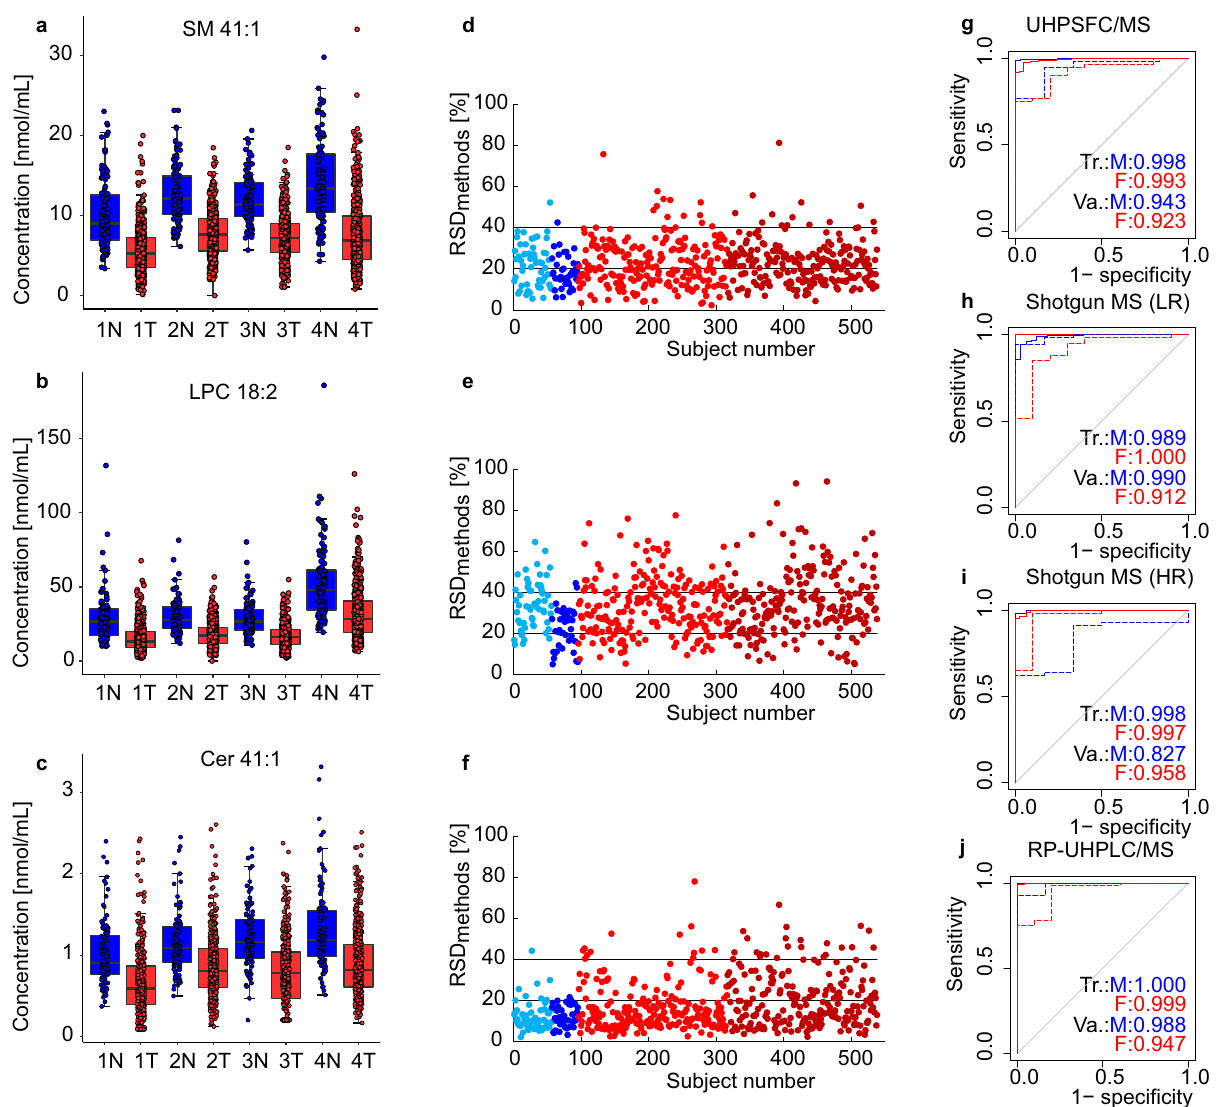
Fig. 4 Comparison of Phase II results obtained at three different laboratories using four mass spectrometry-based approaches. Box plots of lipid concentrations normalized to the NIST reference material for samples obtained from PDAC patients (443 T) and healthy controls (95 N) of both genders including both validation and training sets: a SM 41:1, b LPC 18:2, and c Cer 41:1 for UHPSFC/MS (Method 1), shotgun MS (LR) (Method 2), shotgun MS (HR) (Method 3), and RP-UHPLC/MS (Method 4). In each box plot, the centerline represents the median, the bounds represent the 1st and 3rd quartile and whiskers span 1.5 fold inter-quartile range from the median. The RSD of the concentrations obtained by four methods for each sample d SM 41:1, e LPC 18:2, and f Cer 41:1. Color annotation: light blue — control females, blue — control males, red — cancer females, and dark red — cancer males. ROC curves for males (M) and females (F) in training (Tr.) and validation (Va.) sets: g UHPSFC/MS, h shotgun MS (LR), i shotgun MS (HR), and j RP-UHPLC/MS. Source data are provided as a Source Data fi le. independent of cancer stages, and concentrations in pancreatitis The diabetes mellitus is connected with a dysfunction of the samples are similar to control samples. These results suggest that pancreas, the effect of diabetes on the lipid pro fi les was lipidomic pro fi ling may be applicable for differentiation of investigated by the comparison of lipid concentrations of subjects pancreatitis from PDAC samples, but the con fi rmation with a with and without diabetes mellitus for case and control groups for higher sample number of samples within the frame of a SM 41:1 (Fig. 7f), where no visible effect was observed. prospective study is certainly required. ROC curves for males The overall performance of lipidomic pro fi ling for PDAC and females for training and validation sets provided AUC values screening was compared to the clinical established CA 19-9 over 0.90 (Fig. 7a). The effect of age on the most dysregulated biomarker for monitoring the progress of PDAC. Cut-off values lipid species was also visualized for all 830 samples in Phase III for CA 19-9 do not differ for genders, therefore the MDA for (Fig. 7d, e). Lipid concentrations were overall similar for lipidomic pro fi ling was performed for both genders as well. individual age groups, with the exception of slightly elevated Moreover, the comparison was also done for the combination of lipid concentrations for SM 41:1 and LPC 18:2 for cancer patients lipidomic pro fi ling and CA 19-9 to predict sample groups as well younger than 39 years old (Fig. 7d, e), but this observation could be in fl uenced by the smaller number of subjects in this age group. analysis of proteins and ctDNA for cancer screening including NATURE COMMUNICATIONS| (2022) 13:124